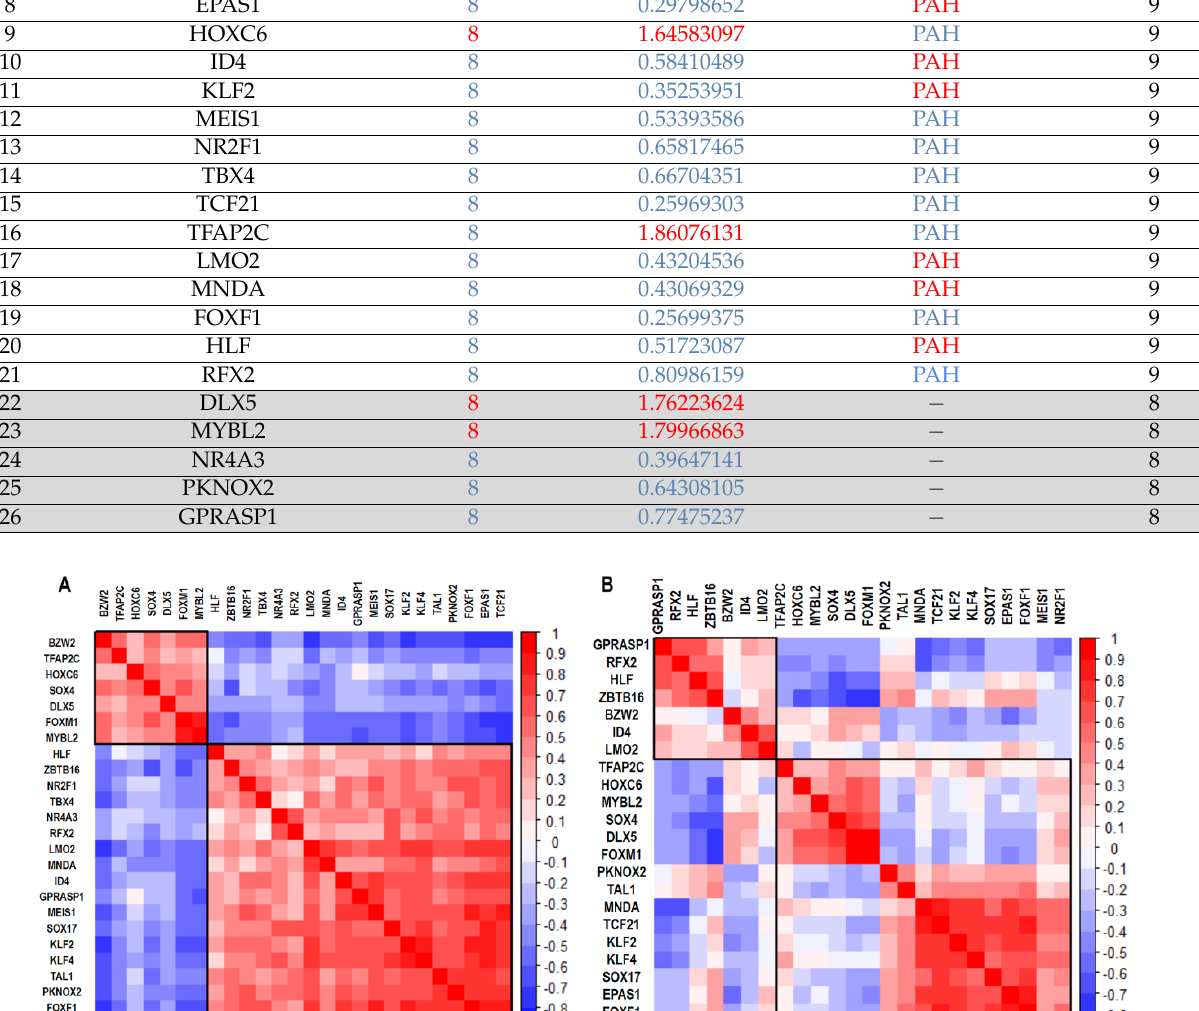
4.395 Figure 3. Common connection pattern (CCP) of all lung cancer co-expression networks and pulmo- nary arterial hypertension co-expression networks. In green are the two main regulators of the genes (magenta) in the CCP.